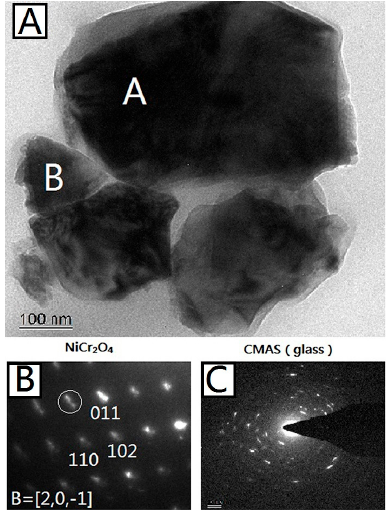
Figure 5. ( A ) Bright-field TEM micrograph of 50%CMAS-50%NiCr 2 O 4 powder interacted under 1200 °C for 24 h. Phase-identified NiCr 2 O 4 and CMAS (glass) grains are marked; ( B ) Indexed SAEDP of NiCr 2 O 4 marked with A in ( A ); ( C ) Indexed SAEDP of CMAS marked with B in ( A ). Table 3. EDS cation compositions (at %) of NiCr 2 O 4 (area A) and CMAS (area B) in Figure 5A. At % Ca Mg Al